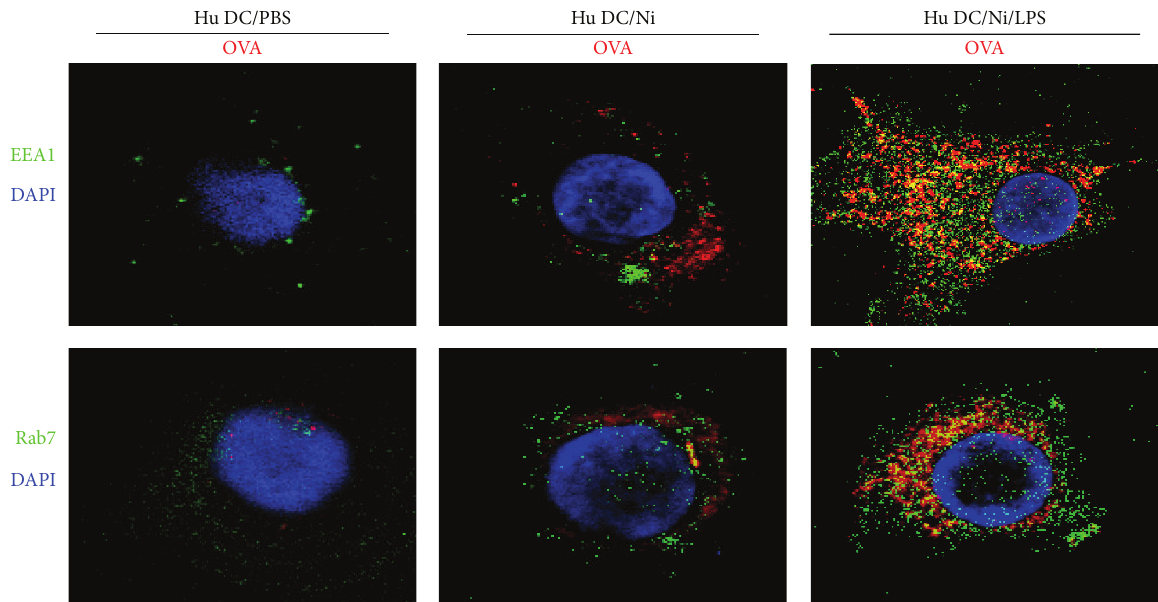
Figure 3: The exposure of traces of LPS increases the endosomal translocation of antigen in human semimature DCs. DCs derived from human PBMC with recombinant human GM-CSF and IL-4 were conferred with nicotine (10 −7 mol/L) 12 ∼ 15 h stimulation. Then, the DCs wereexposed to60 minendotoxin-freeEndoGrade-ovalbumin (50 𝜇 g/mL)pulseand 20min LPS(1ng/mL)stimulation . Theeffect ofnicotine and LPS on endosomal translocation of antigen was observed by confocal microscope analyses. One representative from 3 independent experiments is shown. Ni: